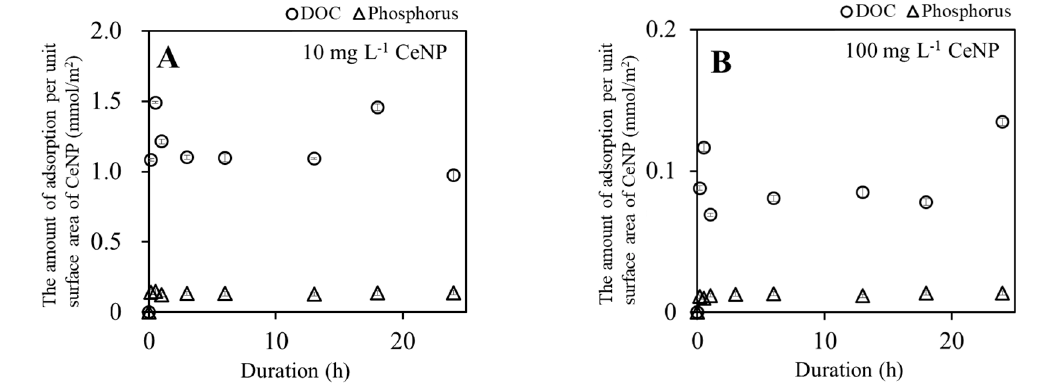
Figure 3. Time-course of the amount of DOC (circle) and phosphorus compounds (cross) adsorbed onto CeNP surfaces from EPS solutions at pH of 6.0. The CeNP concentrations were set to 10 mg L − 1 ( A ); and 100 mg L − 1 ( B ); DOC: dissolved organic carbon.